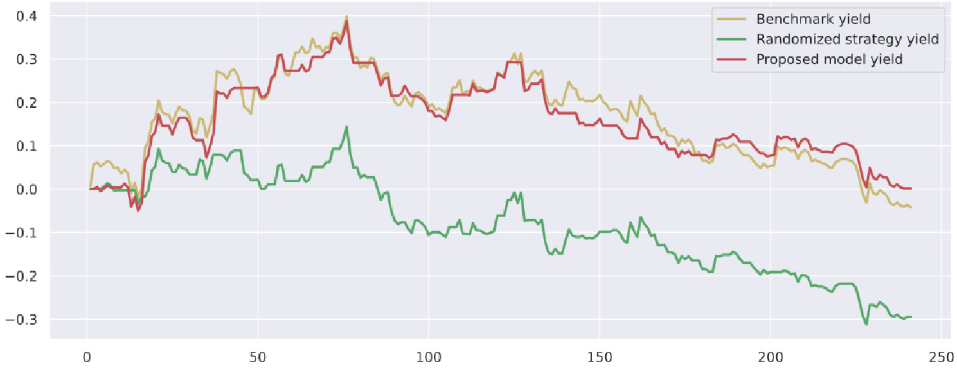
Fig 16. Yonghui supermarket stock strategy